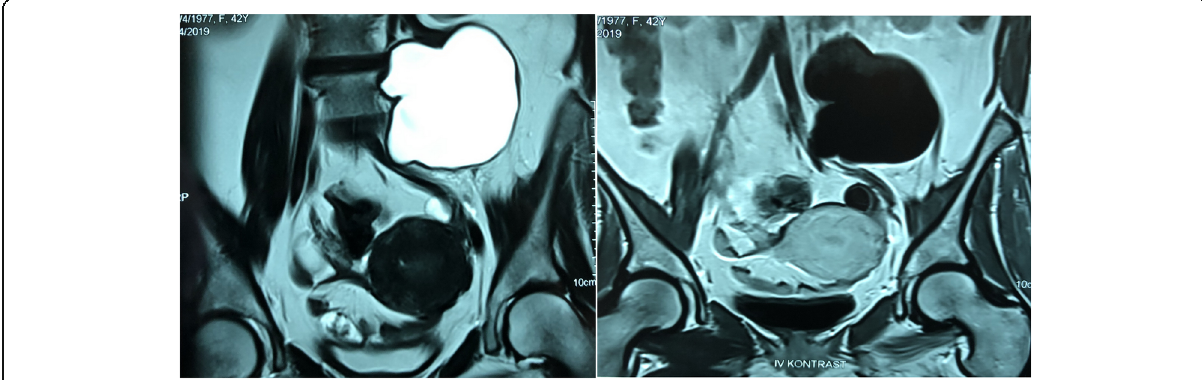
Fig. 1 MRI of the of the lumbar region showing evidence of cystic lesion in the left paravertebral region pressing the psoas muscle and causing atrophy of